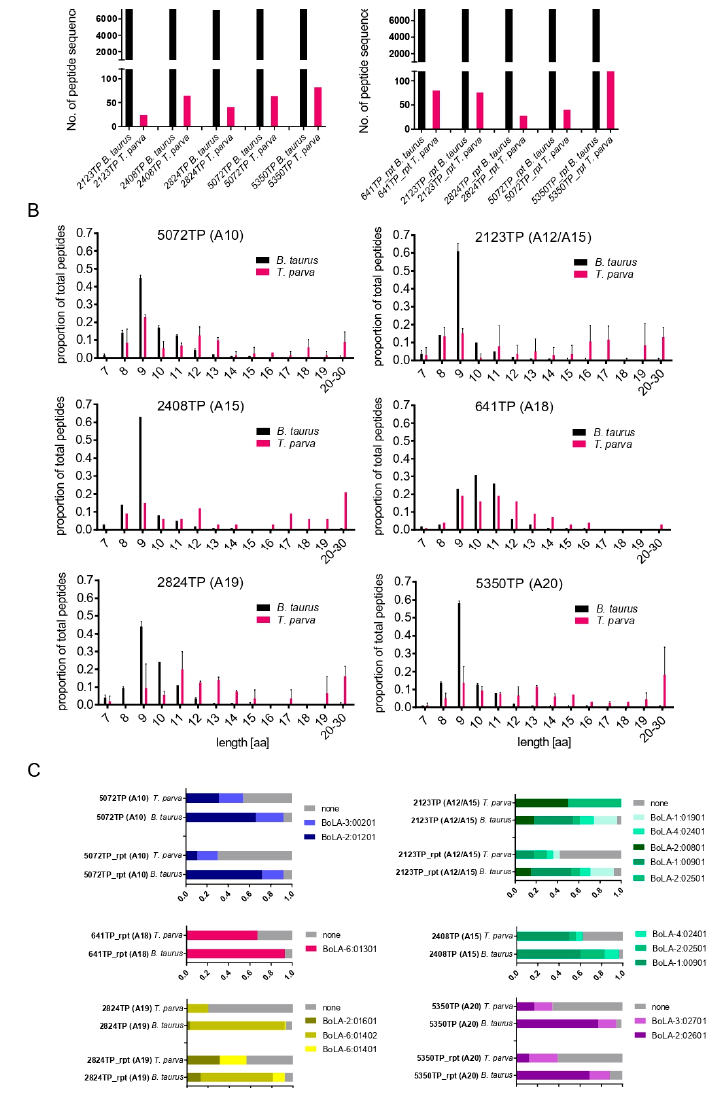
Figure 2. Characteristics of BoLA-I-eluted peptides from 5072TP/5072TP_rpt (A10), 2123TP/2123TP_rpt (A12/A15), 2408TP (A15), 2824TP/2824TP_rpt (A19), 641TP_rpt (A18), and 5350TP/5350TP_rpt (A20) cell lines. ( A ) Number of B. taurus and T. parva peptide sequences identified in each sample. ( B ) Length distributions of B. taurus and T. parva peptides identified in each sample. The horizontal axis shows the length of peptides, and the vertical axis shows the proportion of the peptides identified for each length. For samples that had been analysed in two independent elutions, the data has been amalgamated into a single panel. ( C ) Binding predictions of B. taurus and T. parva 8–12-mer peptides stratified by their predicted BoLA-I allele of origin (peptides with a rank predicted binding score of <2% to a BoLA-I allele were considered to be binders). Peptides predicted to be MHC-binders are represented by coloured blocks, peptides predicted to be non-MHC binders are represented by grey blocks; the size of the blocks is proportional to the number of peptides in the respective